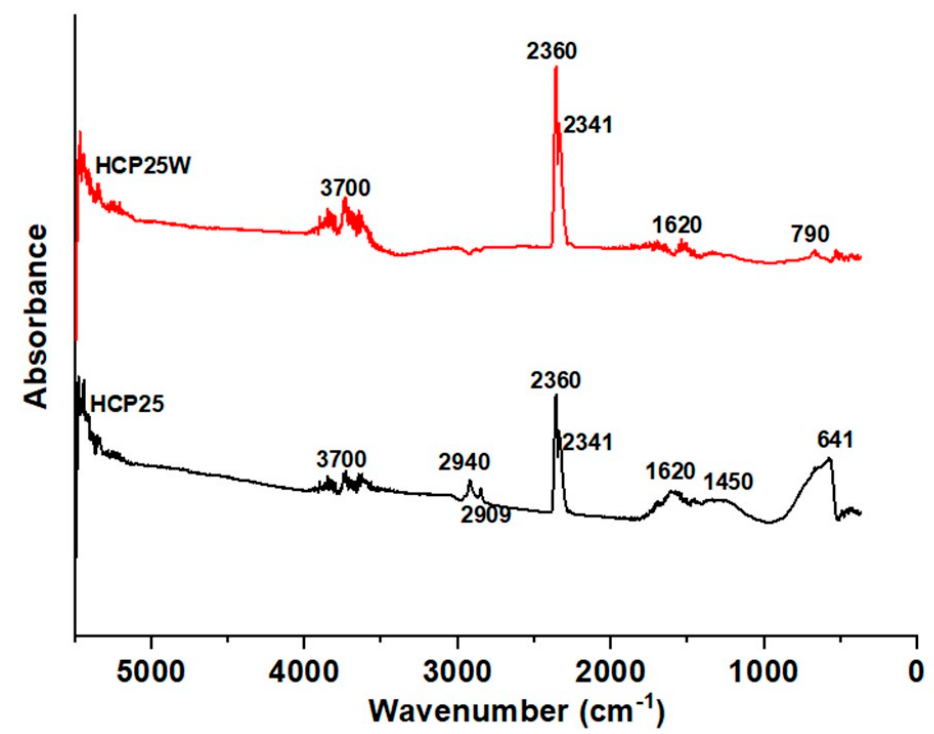
Figure 4. FTIR-ATR spectra of HCP25 and HCP25W.